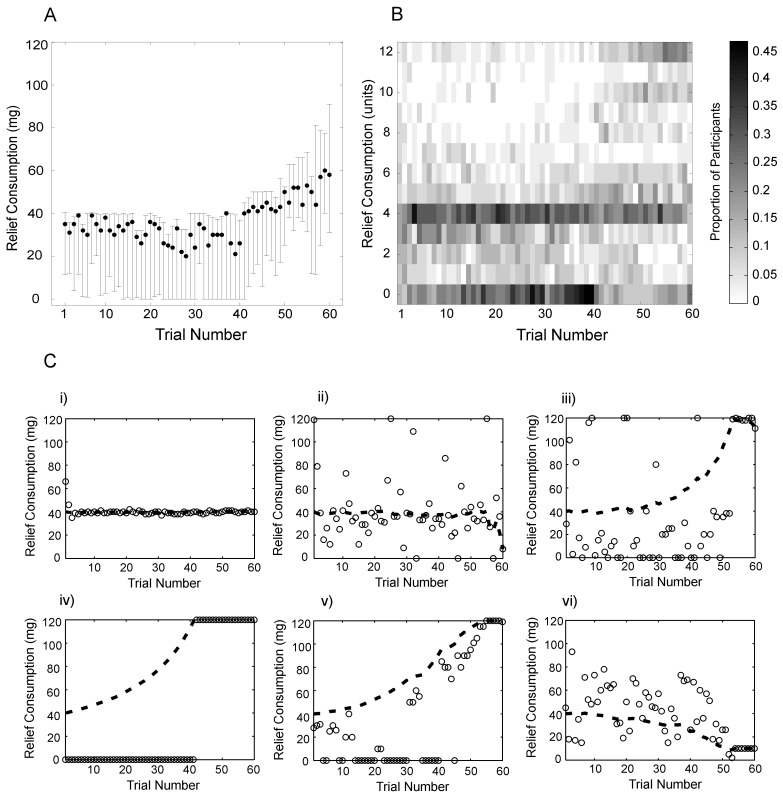
Observed distribution of relief consumption across time.
A Median relief consumption on each trial at the group level is indicated by the solid black circles. Error bars indicate the upper and lower quartiles of consumption. B The distribution of group level consumption. The intensity of the grey bars represents the proportion of the 30 participants included in the analysis choosing to consume each amount of relief on a particular trial. Relief is expressed in units, produced by rounding the raw consumption choices to the nearest 10 units of relief. A tendency to conserve relief is evident from below-average consumption over the first 40 trials and above-average consumption over the last 20 trials. A tendency to spread relief across time is evident from the high proportion of choices to spend 4 units of relief, the mean rounded relief per trial over the whole experimental run. C Consumption paths from six sample participants. Hollow circles denote the consumption choices on each trial. The bold dashed line denotes the mean relief remaining at the start of each trial. These six participants are selected as representative of the key patterns observed. The first two participants (i and ii) on spread relief over time. The subsequent three participants (iii-v) predominantly conserve relief, as evidenced by an increase in the mean relief remaining per trial over time. Participant vi) consumes above the mean relief remaining towards the start of the session and subsequently adjusts consumption downward.